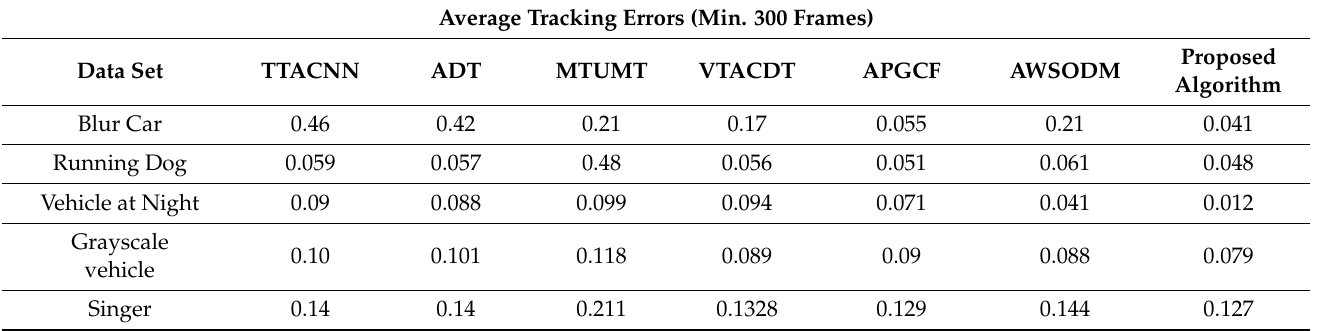
Table 2. Comparison of different techniques based on Average Tracking Errors. Average Tracking Errors (Min. 300 Frames)